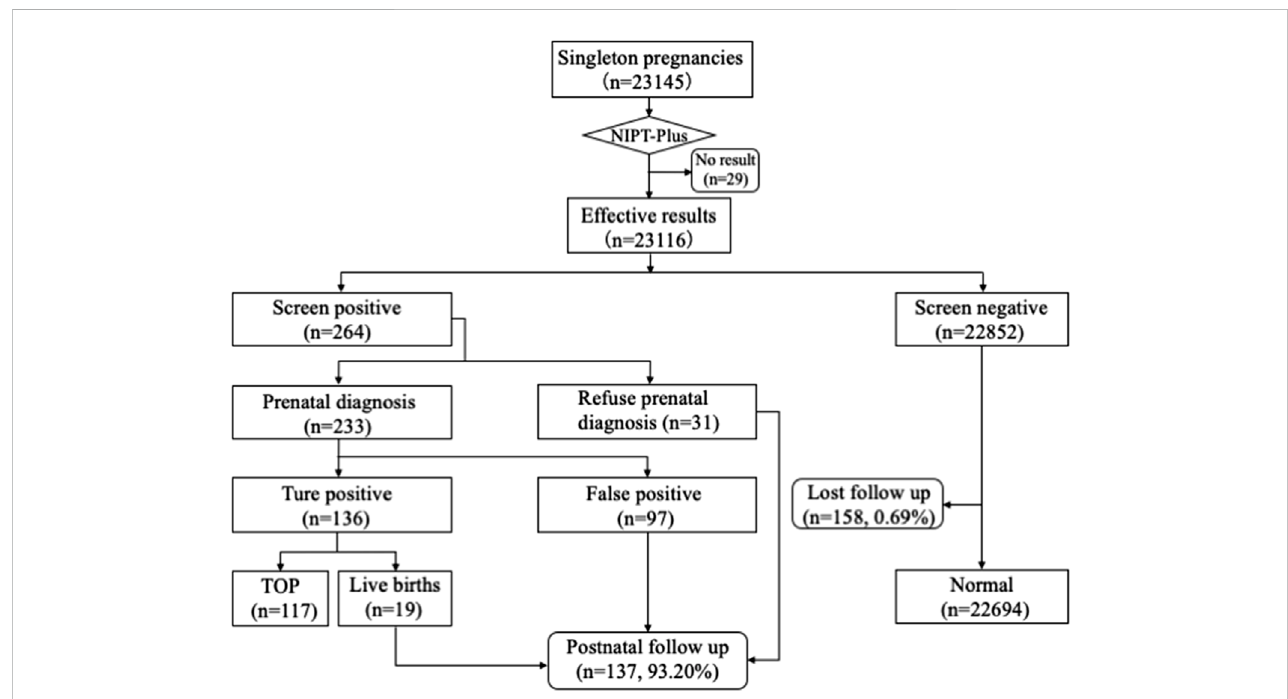
FIGURE 1 Flowchart of NIPT-Plus results and outcomes of pregnant women. TOP, termination of pregnancy.